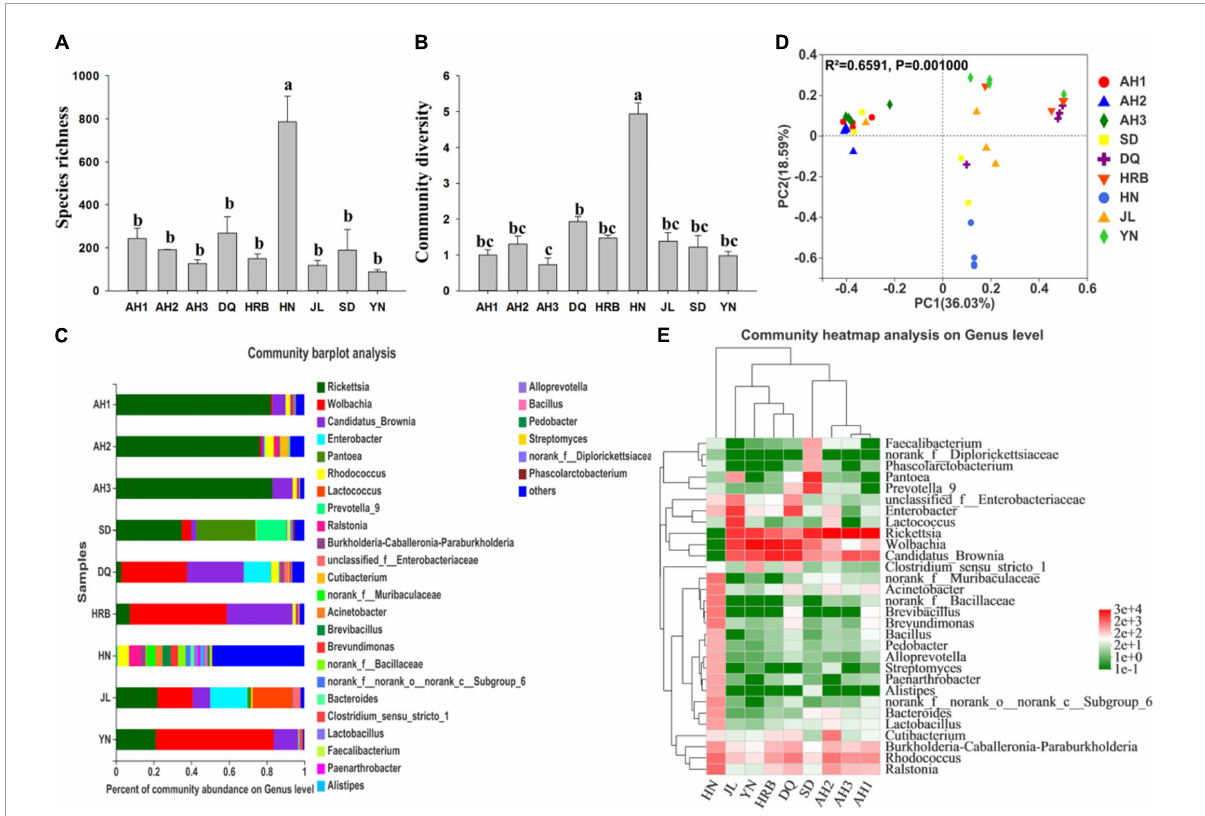
FIGURE2 Bacterial community composition within and among nine geographic populations of the hemp flea beetle P. attenuata in China. (A) Histogram of species richness (number of OTUs). (B) Histogram of community diversity measured by Shannon index. Letters above each population indicate significant differences (one-way ANOVA, Tukey test, P < 0.05, see Table 3 ) in the mean values. (C) Relative abundance of bacterial genera in different populations. (D) Principal components analysis (PCoA) plots of bacterial communities based on the Bray-Curtis distance. Each symbol or color represents a sample. The significant differences in beta diversities were analyzed using Adonis analysis with 999 permutations, P < 0.05. (E) Heatmap showing the relative abundance of top thirty bacterial genera. Hierarchical cluster analysis was based on the Bray-Curtis distance with average